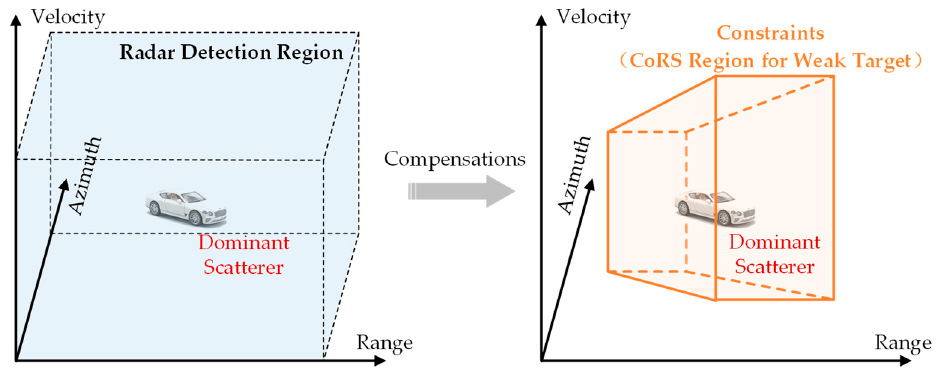
Figure 4. Conceptual diagram of constraints for the compensation using the dominant scatterer.